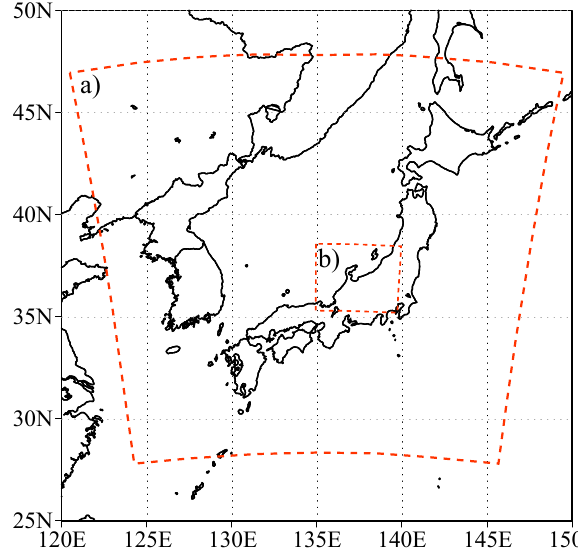
Fig. 2. Domains of the WRF model: (a) the parent domain (in 18- km spatial resolution); (b) the inner domain (in 4.5-km spatial res-